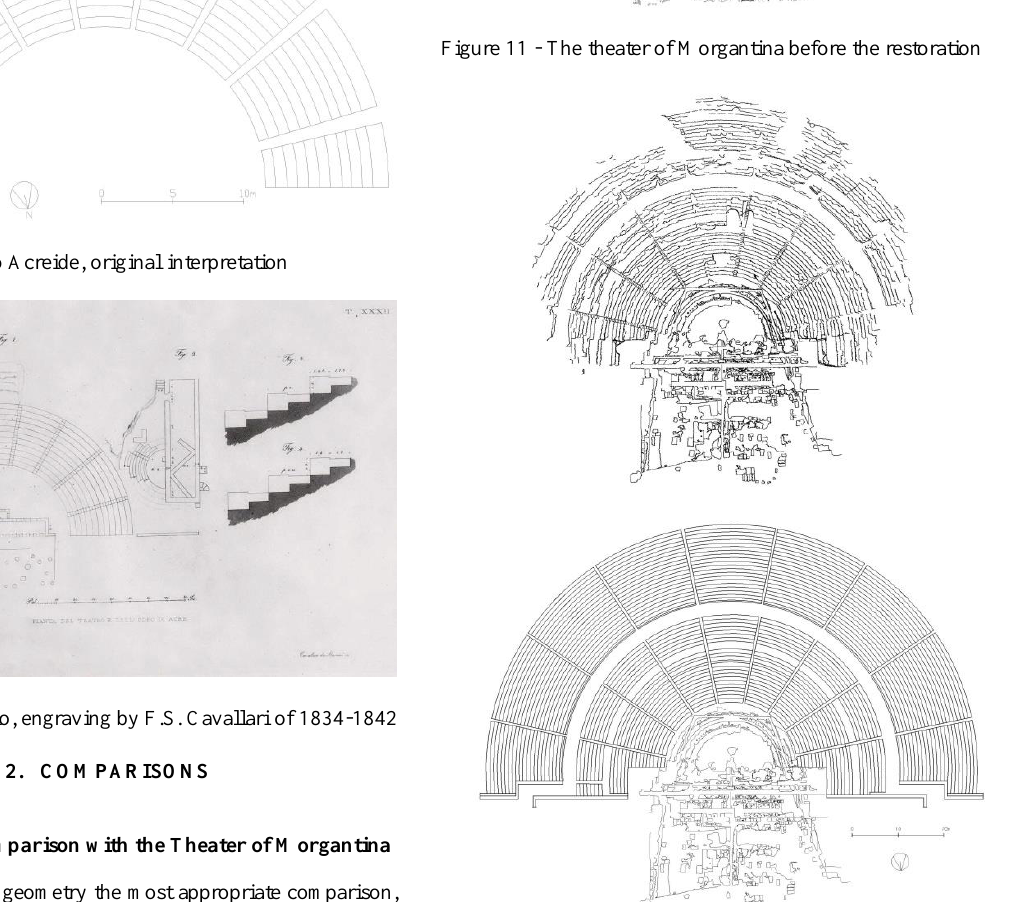
Figure 12 - The Syracuse theatre, restitution and